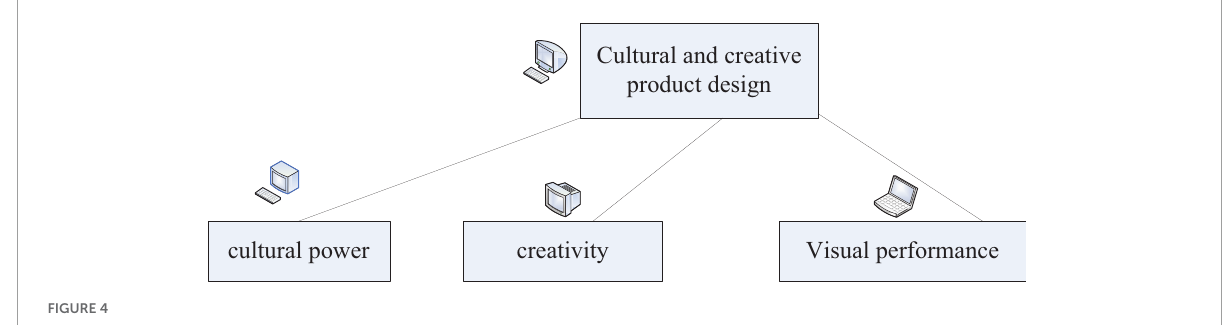
FIGURE4 Criteria for cultural and creative product